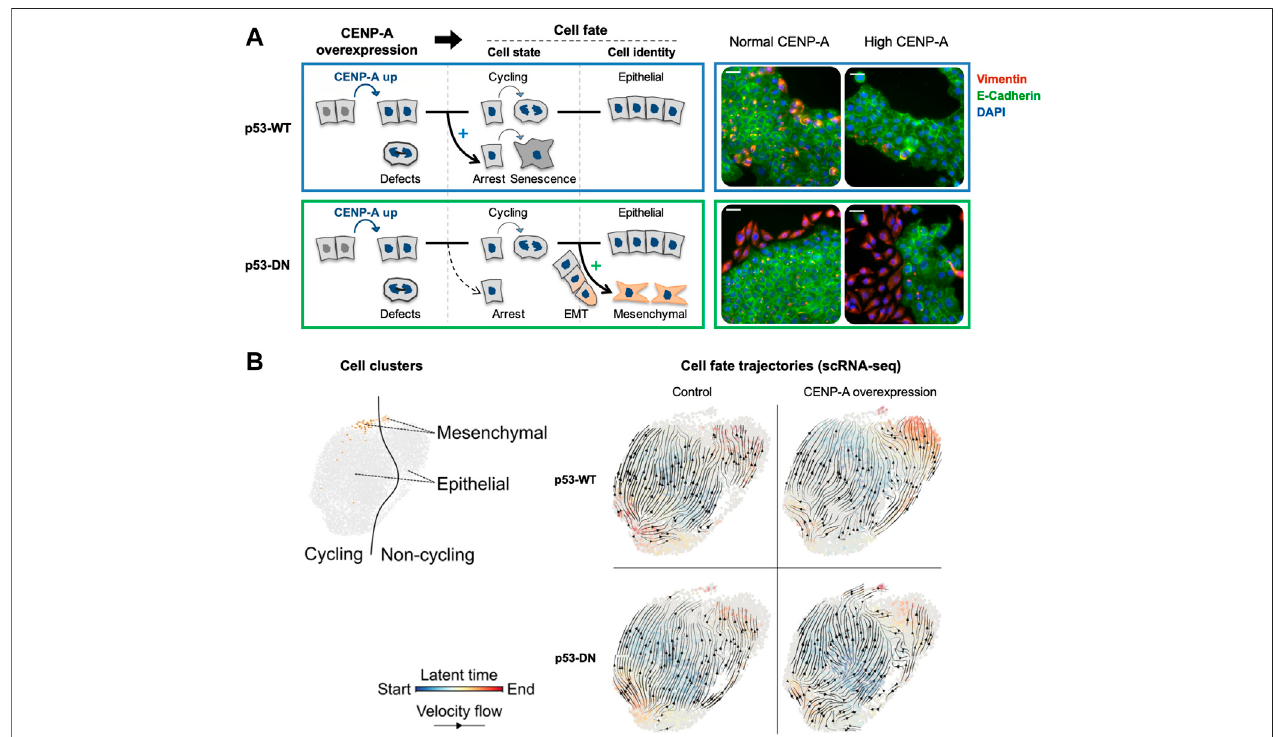
FIGURE 4 | CENP-A overexpression promotes distinct cell fates depending on p53 status. Modi fi ed from Jeffery et al., 2021 . (A) Scheme summarizing the consequences of CENP-A overexpression (in blue) on cell state and identity, in wild-type p53 (p53-WT, top panel blue) and p53-defective cells (p53-DN, dominant negative, bottom panel green). IF images show representative max intensity projections after 34 days with or without continuous CENP-A overexpression. DAPI (blue), E-cadherin (green, epithelial marker), and vimentin (red, mesenchymal marker). Scale bars = 40 µM. (B) Cell fate trajectories inferred by RNA velocity analysis of scRNA-seqsamples.RNAvelocities(blackarrows)werecalculatedforeachconditionbystochasticmodelinginindividualsamples.Eachcelliscoloredbytheestimated latent time from initial (blue, start) to terminal states (red, end).